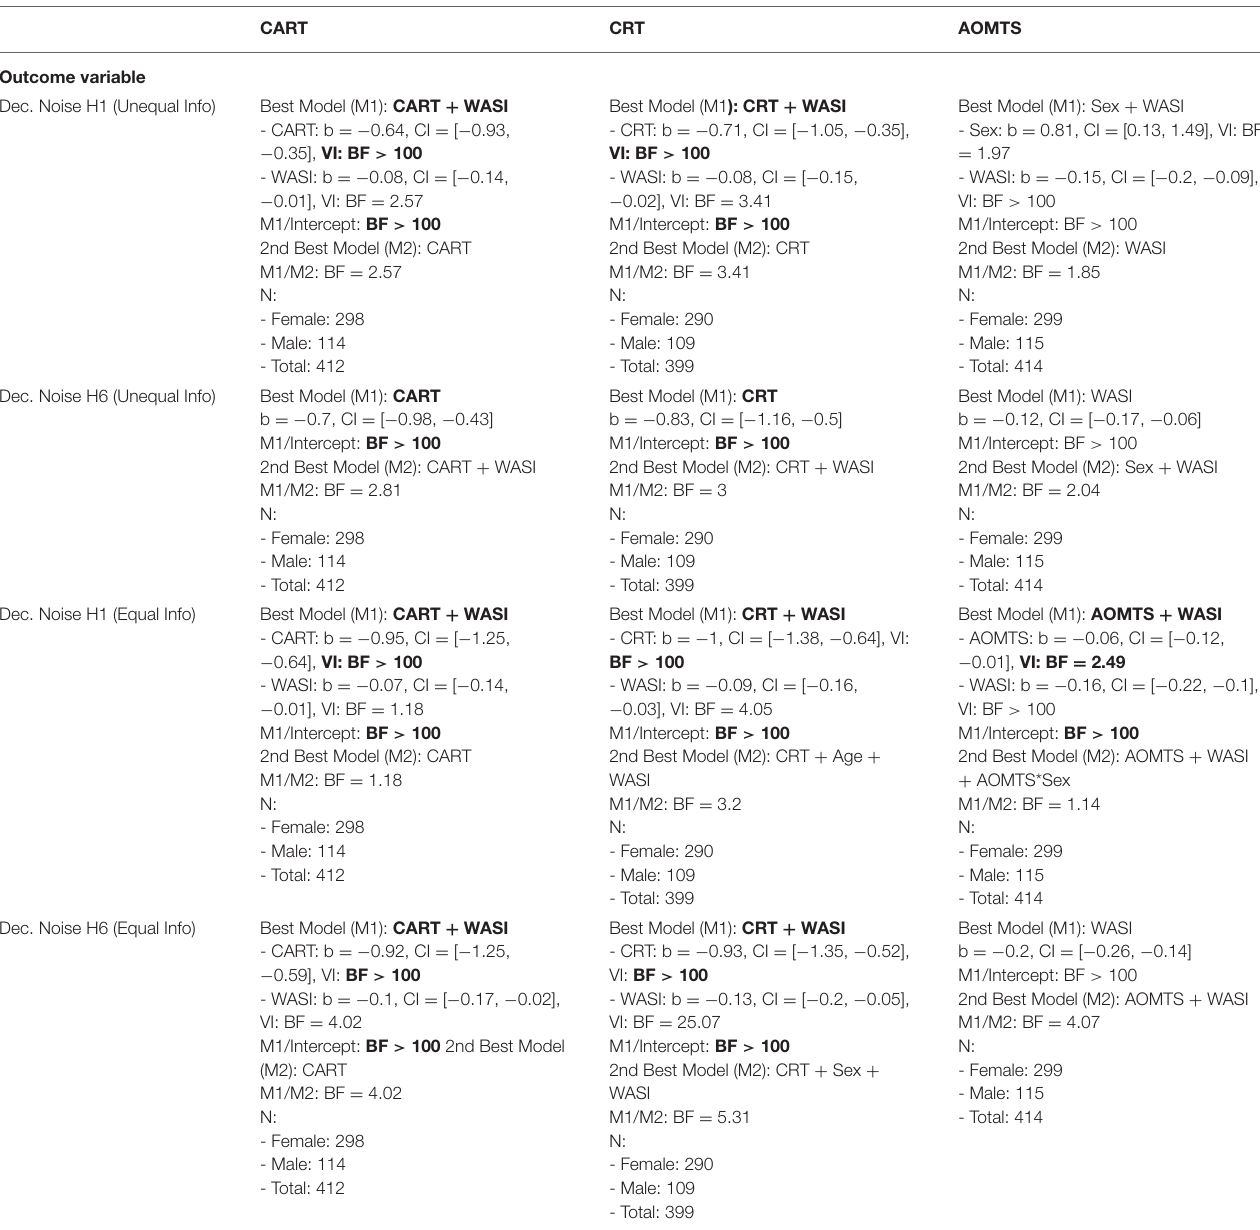
TABLE 6 | Cognitive reflection as a predictor of decision noise. CART CRT AOMTS Outcome